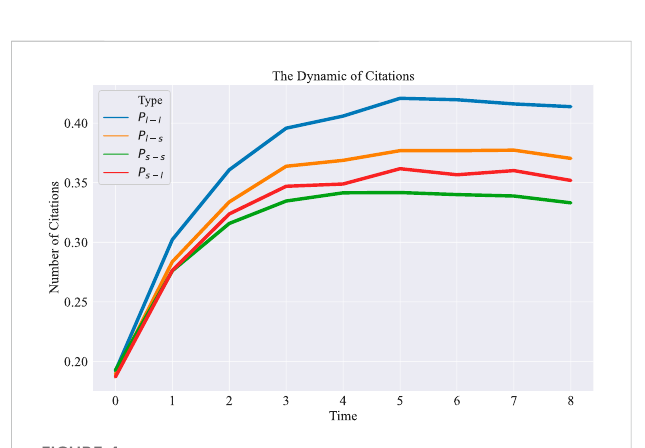
FIGURE 4 The dynamic of citations of papers for different interdisciplinary types.Weselectpaperpublishedbefore2008,andcalculatetheaverage number of citations for different interdisciplinary types, i.e., the large discipline (blue line), the large across the small discipline (orange line),thesmalldiscipline(greenline),andthesmallacrosslargediscipline (red line).